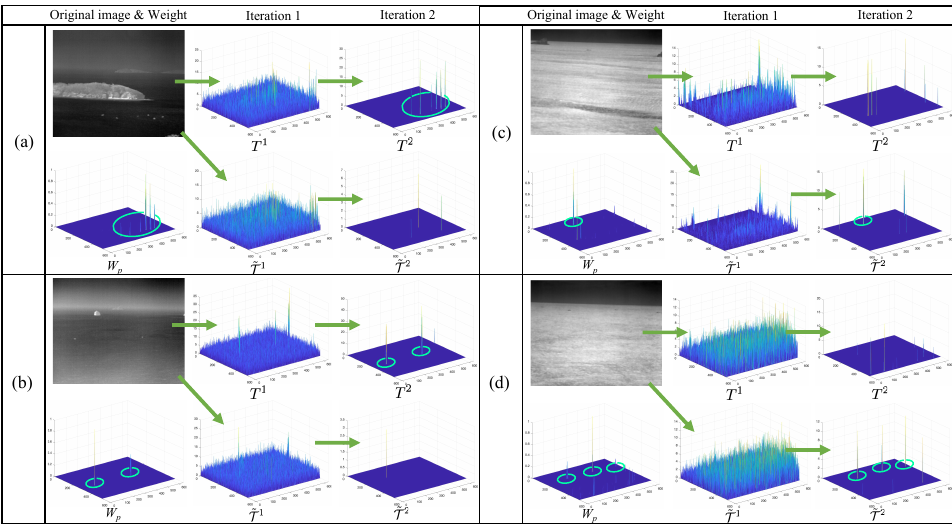
Figure 5. Comparison of sparse components with opposite polarities in the first two iterations and the prior weight for target polarity judgment. ( a – d ) are the results of four different typical scenes corresponding to Figure 1 in the process of